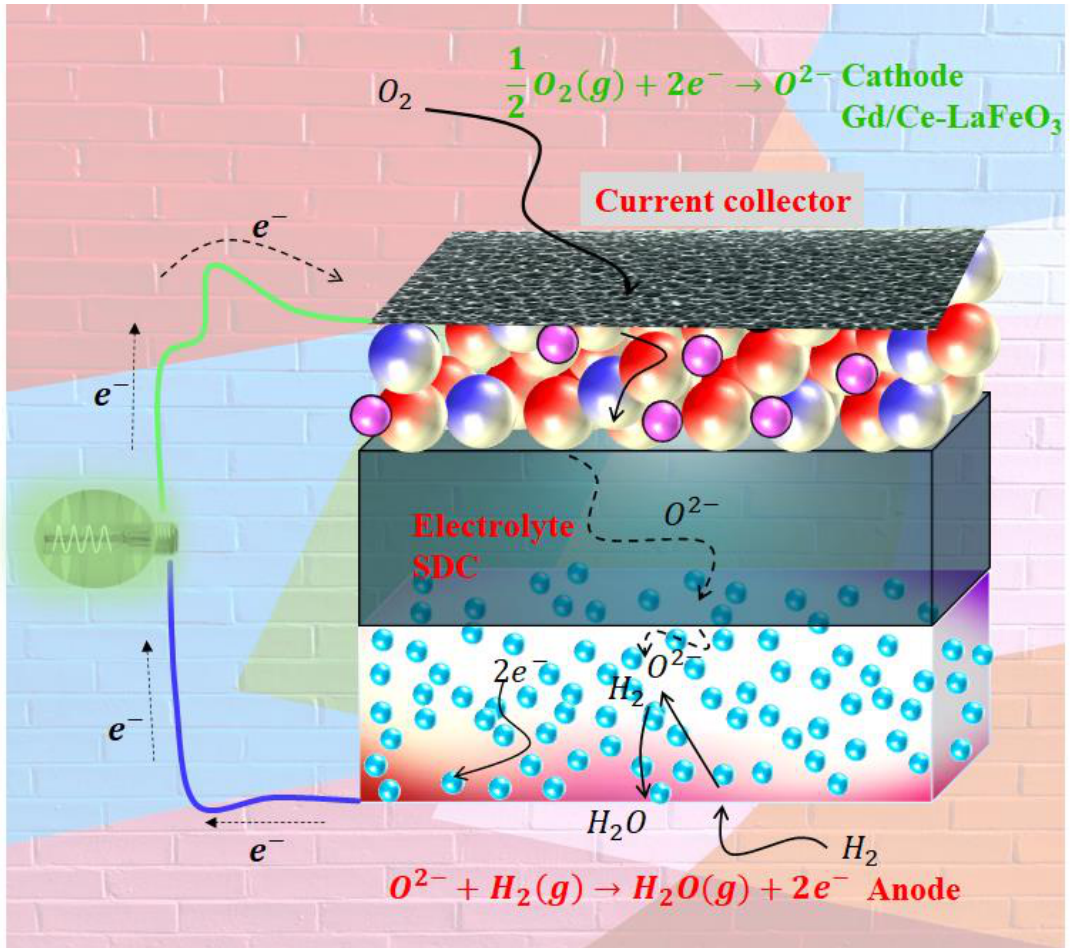
Figure 8. Schematic diagram of the different steps for electrochemical processes from fuel convert- ing the fuel energy into electricity of Gd/Ce-doped LaFeO 3 -based cathode fuel cell over SDC elec-